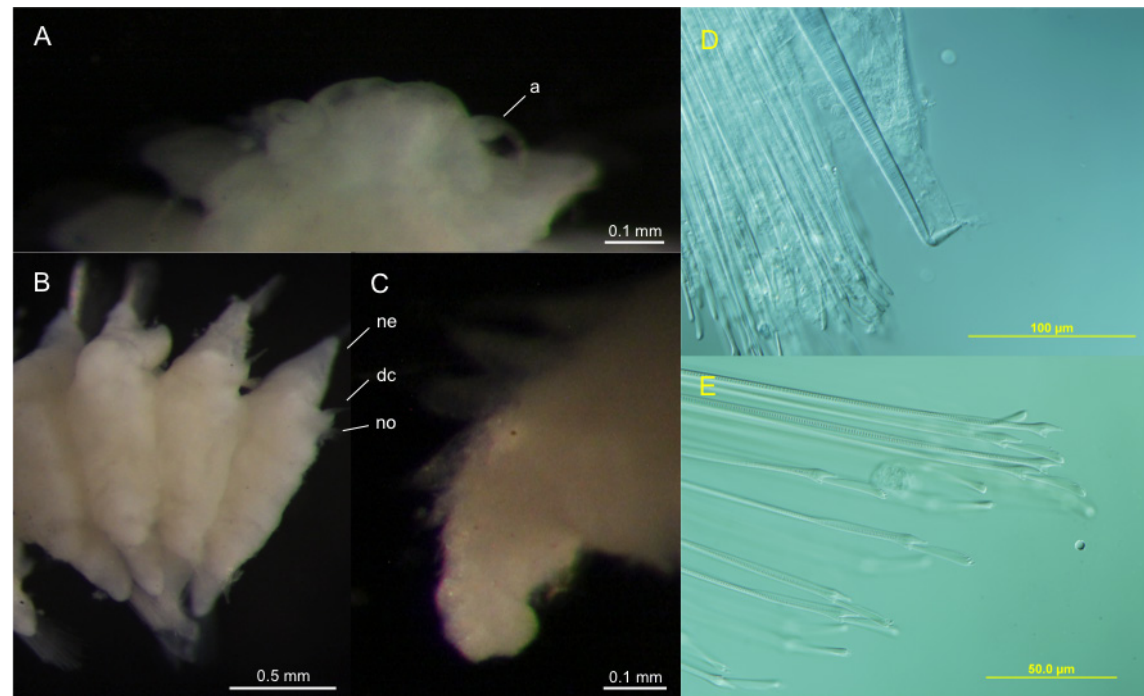
Fig. 4. Craseoschema thyasiricola gen. et sp. nov. Stereo (A–C) and compound (D–E) microscope images. A . Prostomium, dorsal view. B . Median region, dorsal view. C . Pygidium, ventral view. D . Neuroacicula of a median parapodium. E . Neurochaetae of a median